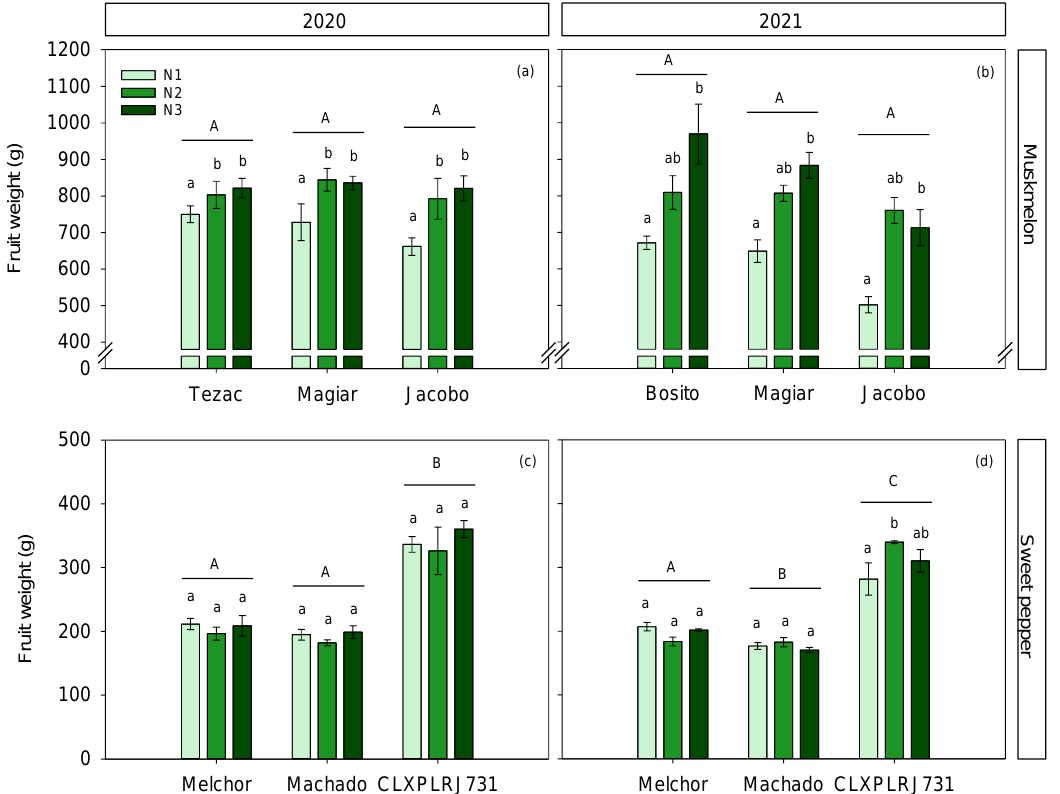
Figure 4. Fruit weight for three cultivars and three N treatments, for muskmelon ( a , b ) and sweet pepper ( c , d ) crops, conducted in 2020 and 2021 years. Different lowercase letters show significant differences between N treatments within each cultivar; different uppercase letters show significant differences between cultivars. Values are means ± SE.